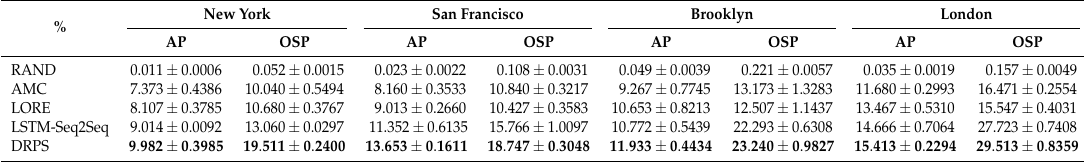
Table 2. Performance comparison on four cities in terms of AP and OSP under the setting where the input and output lengths are, respectively, 30 and 5. The numbers in bold face indicate the ones with the best performances.